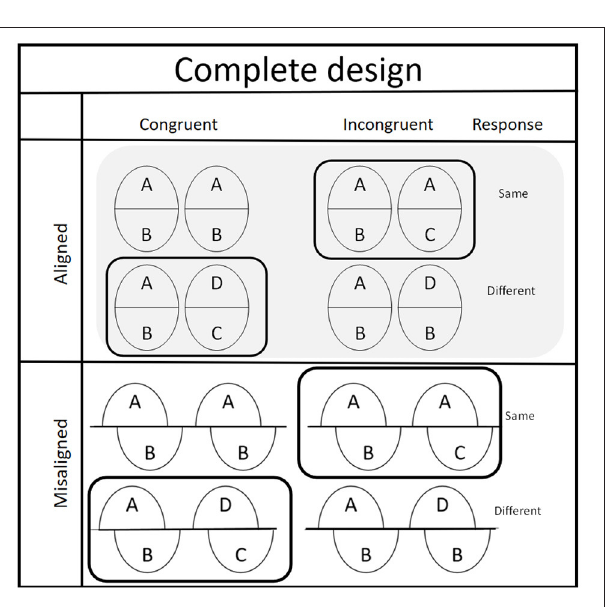
Z (hit) - Z (false alarm)] based on the theory of signal detectability (Green and Swets,